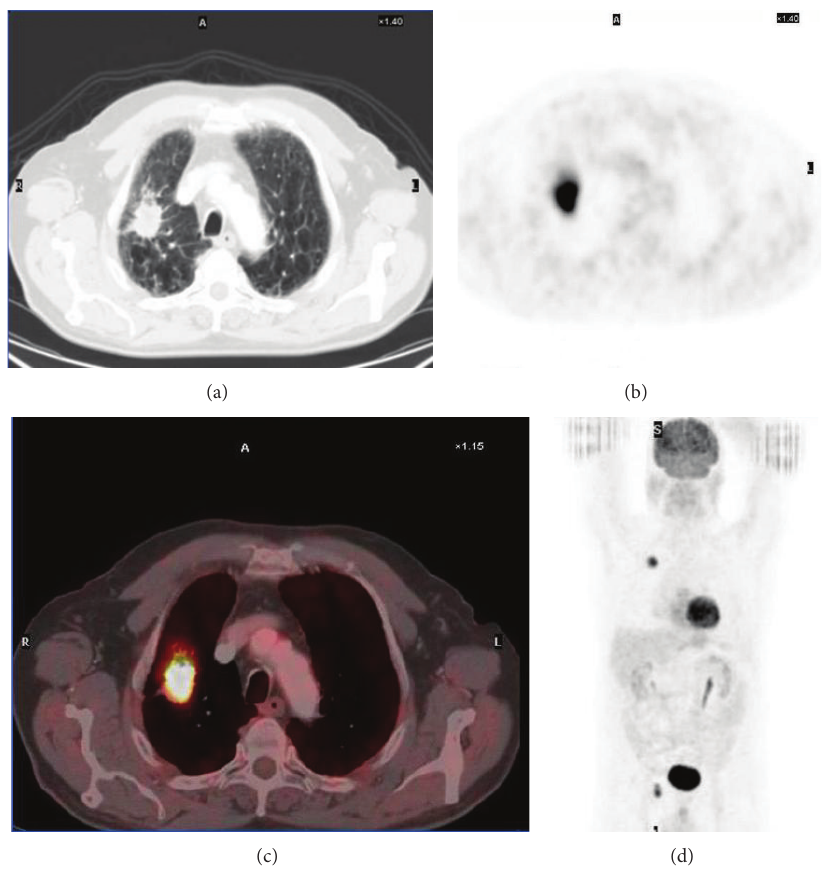
Figure 2: Images for a 60-year-old man. (a) CT image of an NSCLC primary tumor (epidermoid carcinoma) in the right upper lobe. (b) PET image showing intense 18 F-FDG uptake. (c) PET/CT image showing tumor localisation and radiotracer uptake. (d) Coronal whole-body PET